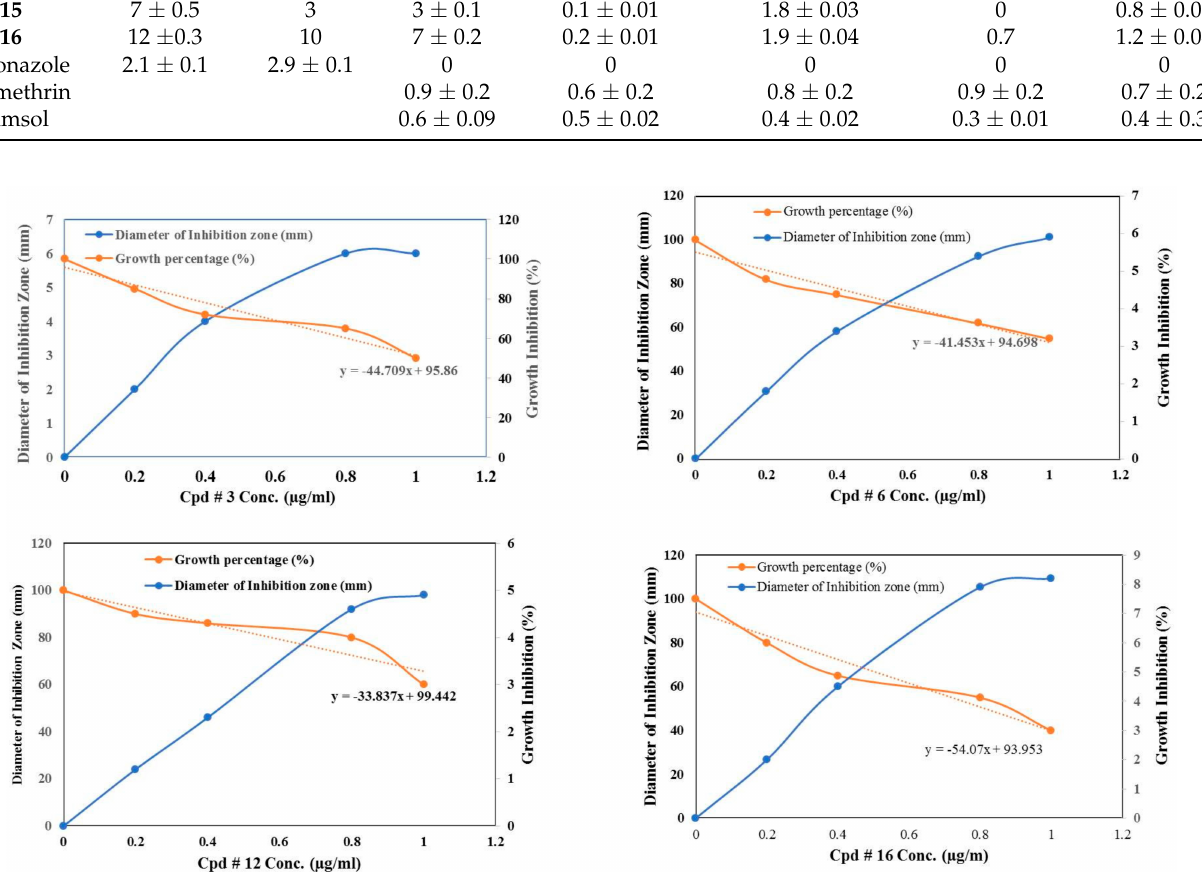
Figure 1. Kinetics of inhibition of the compounds 3 , 6 , 12 and 16 on C. albicans